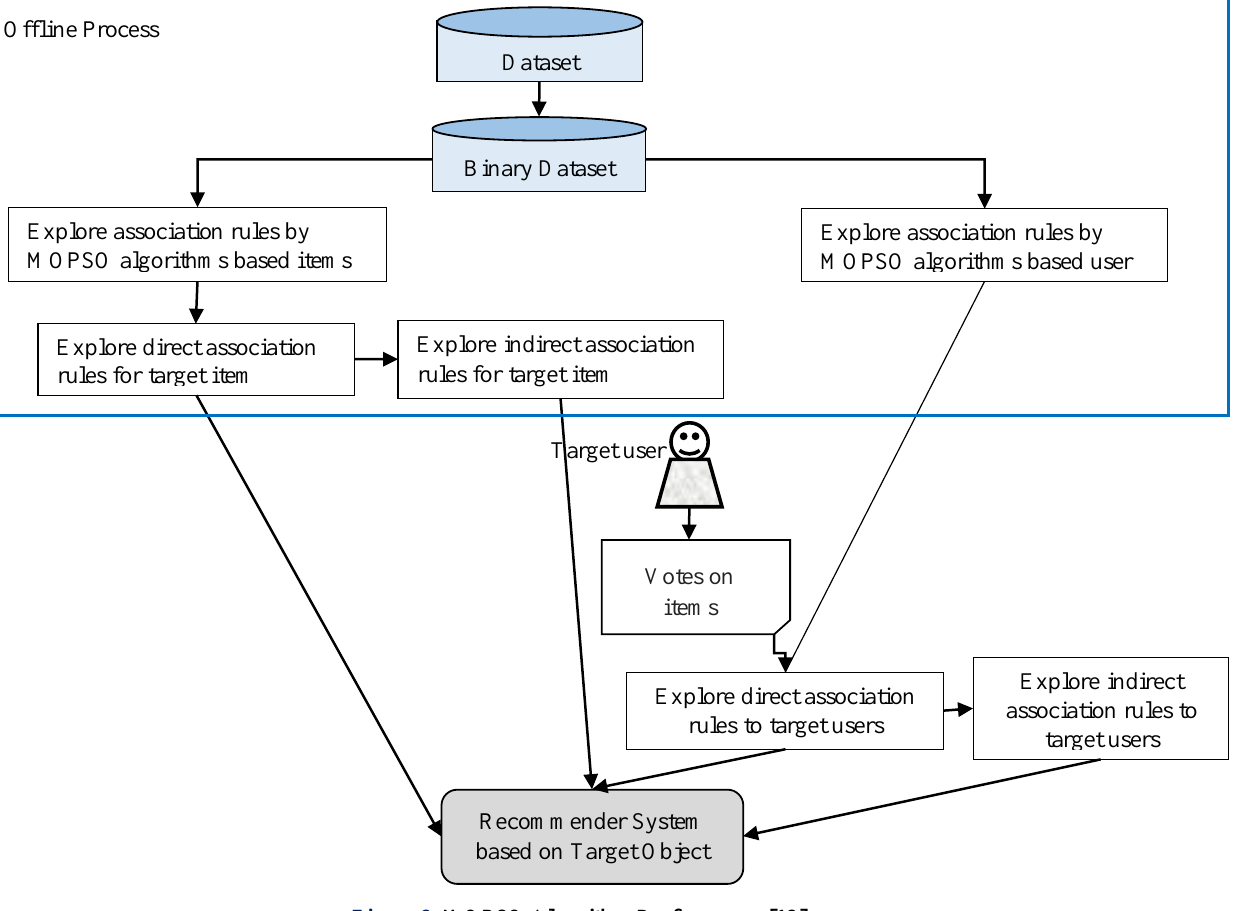
Figure 3. MOPSO Algorithm Performance [13].